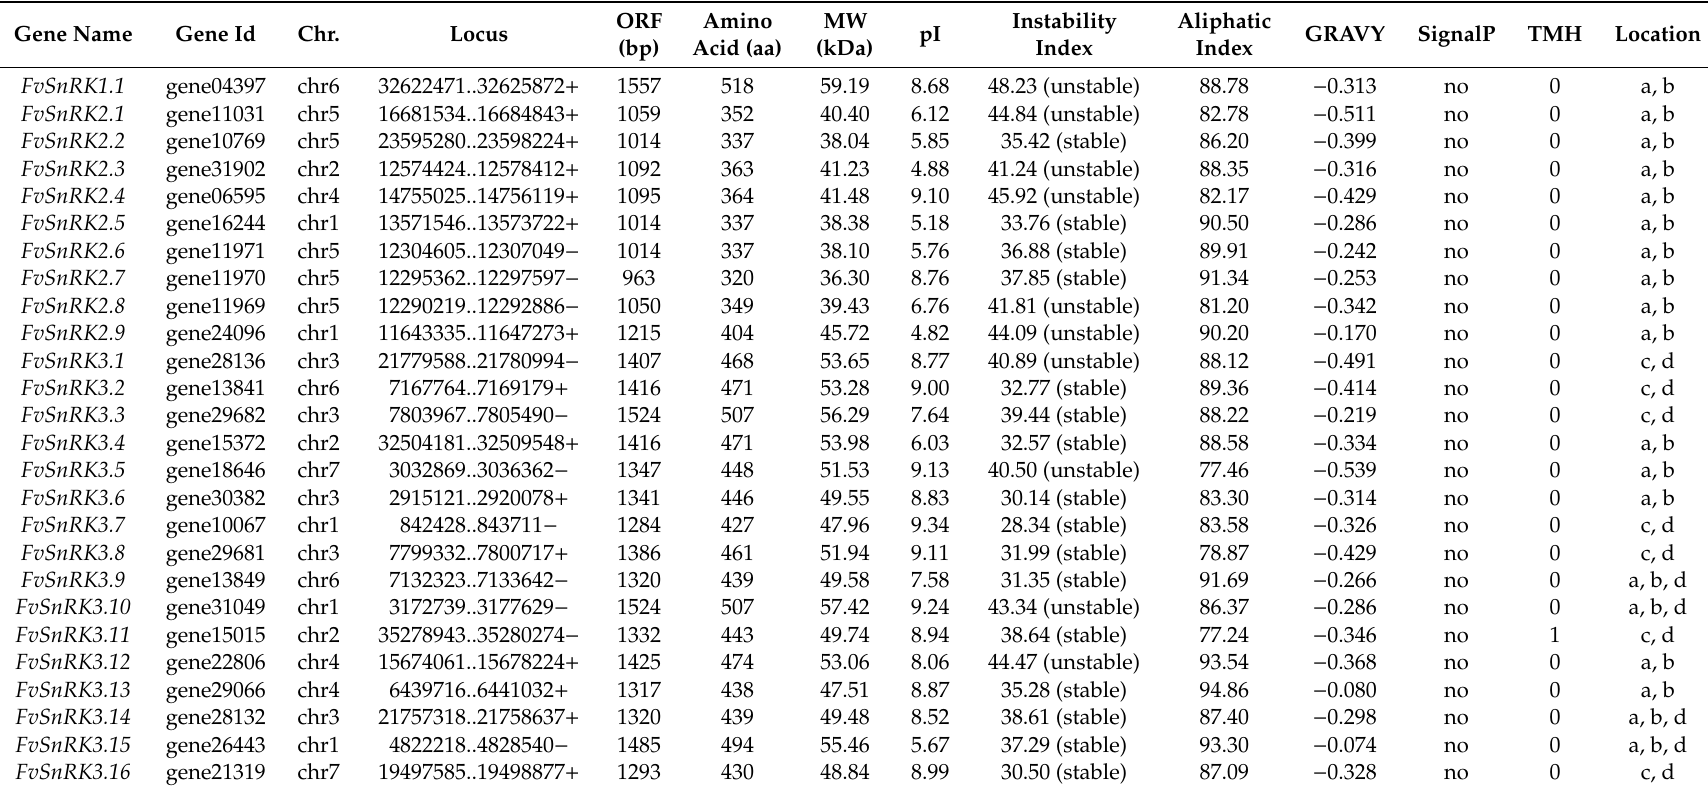
Table 1. Sucrose nonfermenting 1 (SNF1)-related protein kinases ( SnRKs ) genes and corresponding protein properties in